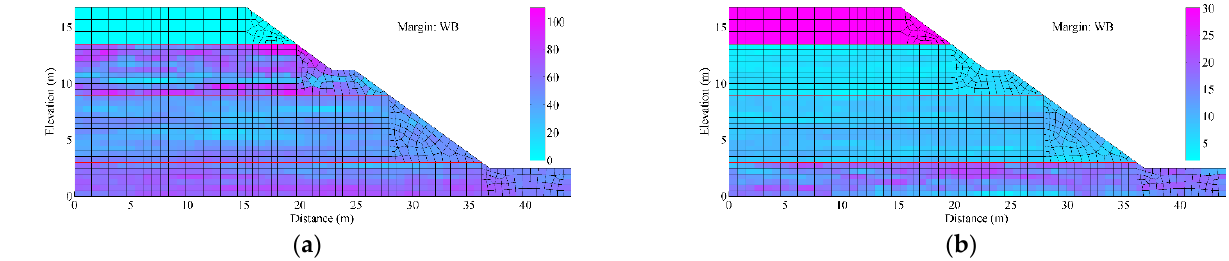
Figure 23. A typical realization of transversely anisotropic CCRF yielded by strategy 7. ( a ) Random field of c. ( b ) Random field of ϕ.